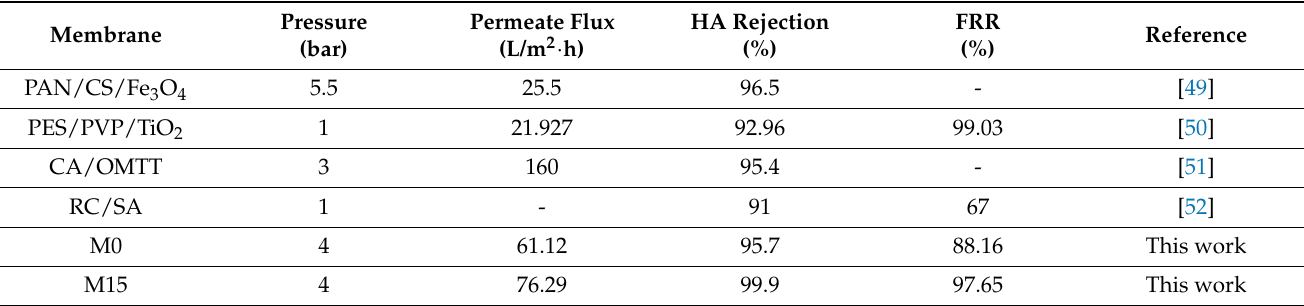
Table 5. Comparison of permeate flux, HA rejection, and FRR reported by literatures with prepared membranes in this